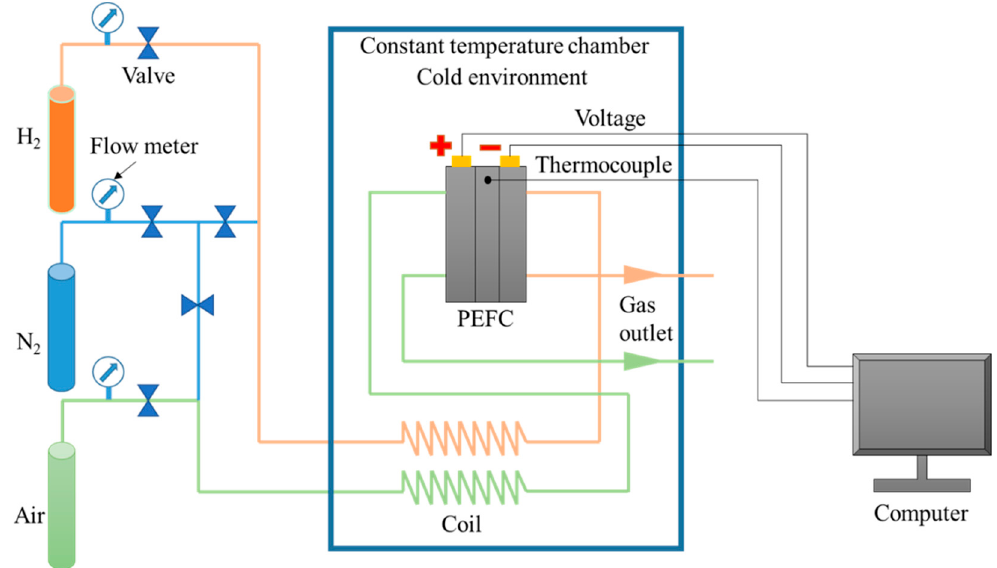
Figure 3. Experimental system for the low-temperature start of PEMFC.